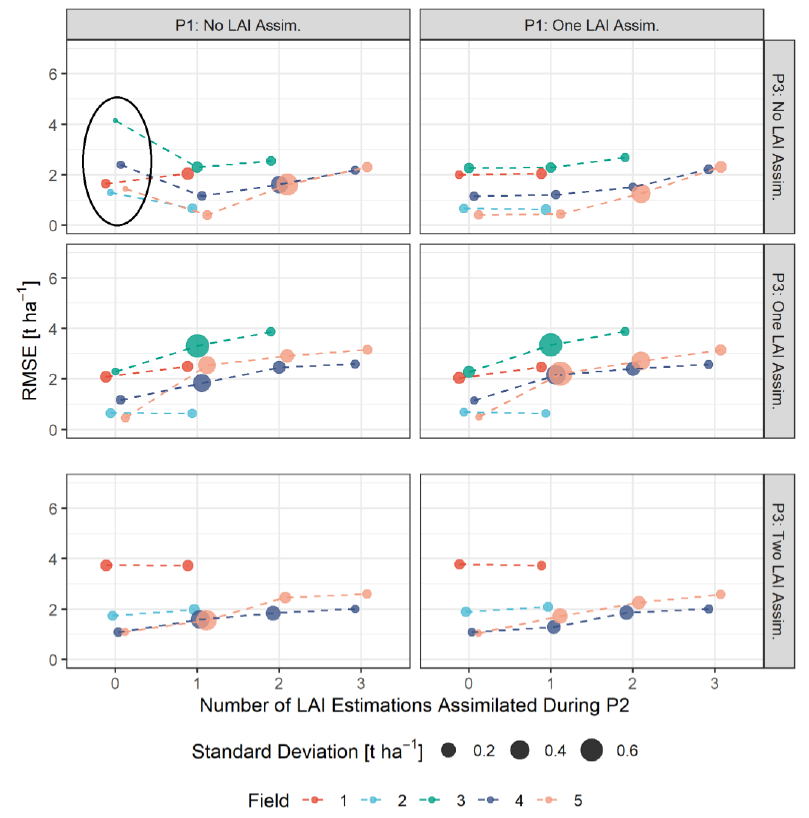
Figure 4. Mean RMSE of total aboveground biomass predictions for fields 1–5. Matrix of panels defined by the number of LAI estimations assimilated during phenophase 1 (P1, columns) and the number